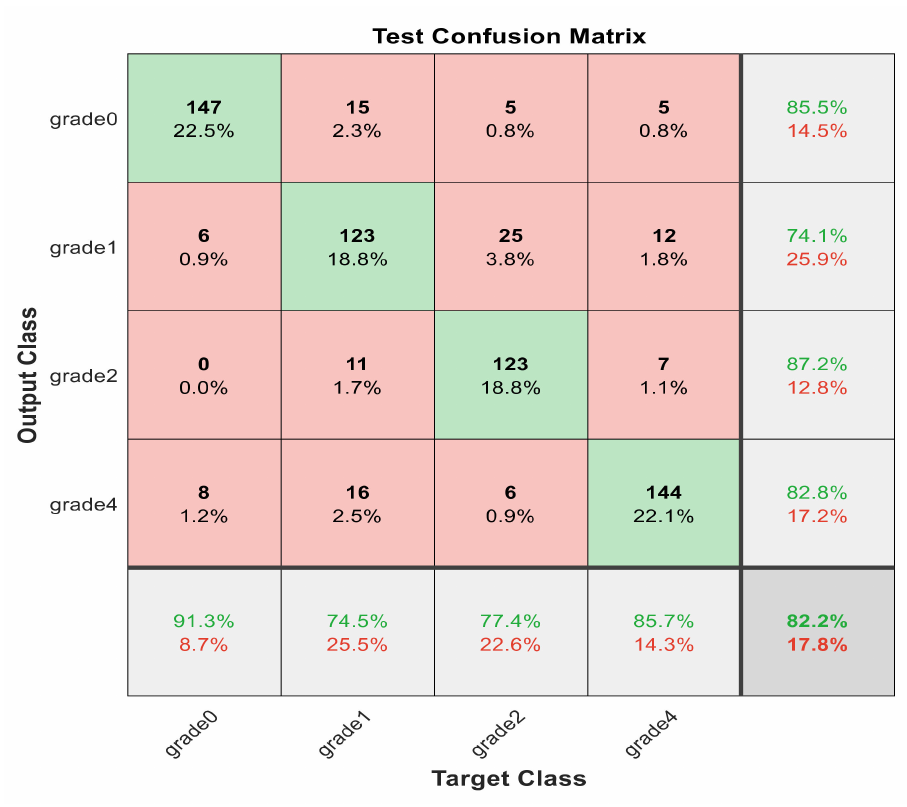
Figure 12. The confusion matrix with PCA-reduced features for grade grading.